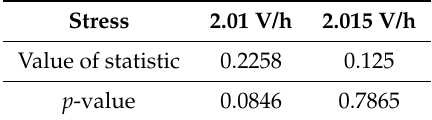
Table 2. K–S statistic and corresponding p -values for each stress level.